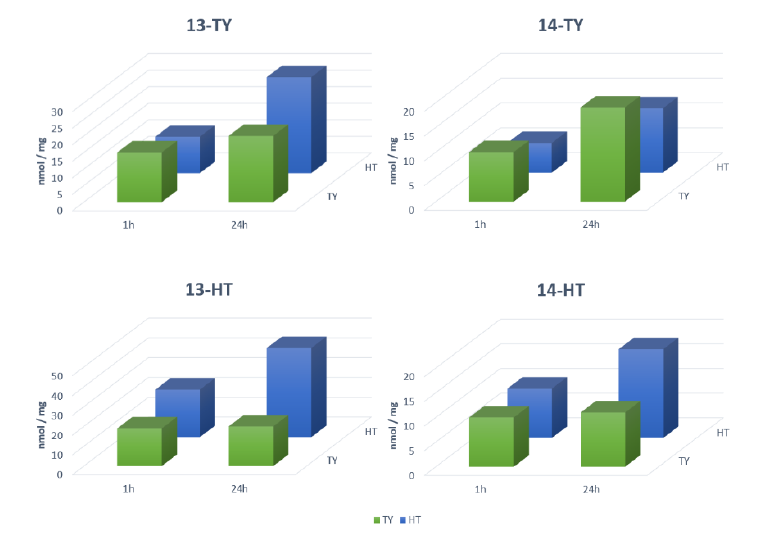
Figure 5. Competition tests for MIPs 13-TY, 14-TY, 13-HT and 14-HT towards the templates TY and HT.